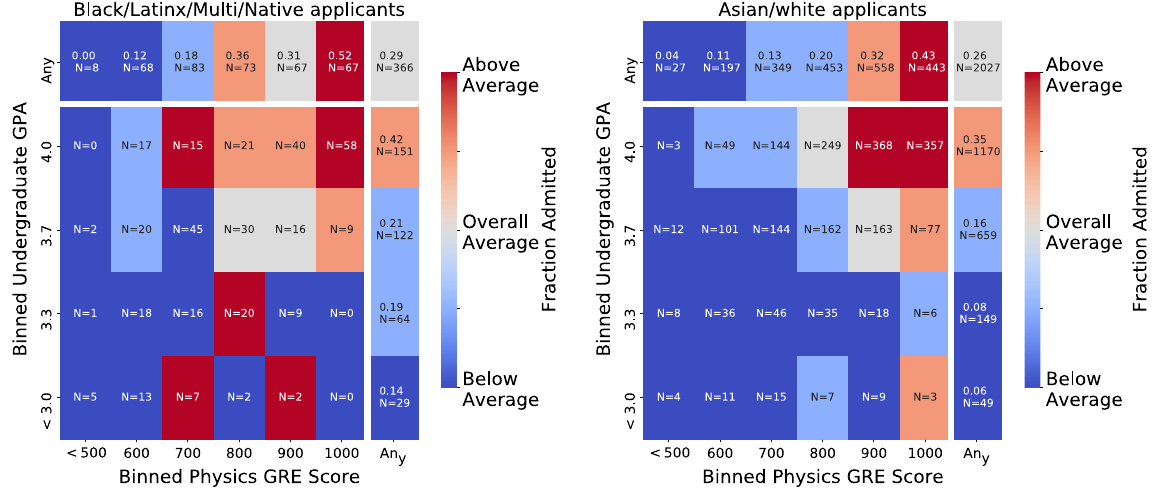
FIG. 8. Fraction of applicants admitted by undergraduate GPA and physics GRE score and split by the applicant ’ s race.